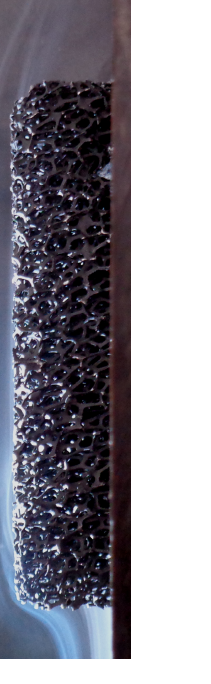
Figure 12. Visualization of the air flow through the in-house-made aluminum foam heat sink (reticulated22) using smoke ( ∆ T = 70 ◦ C, vertical